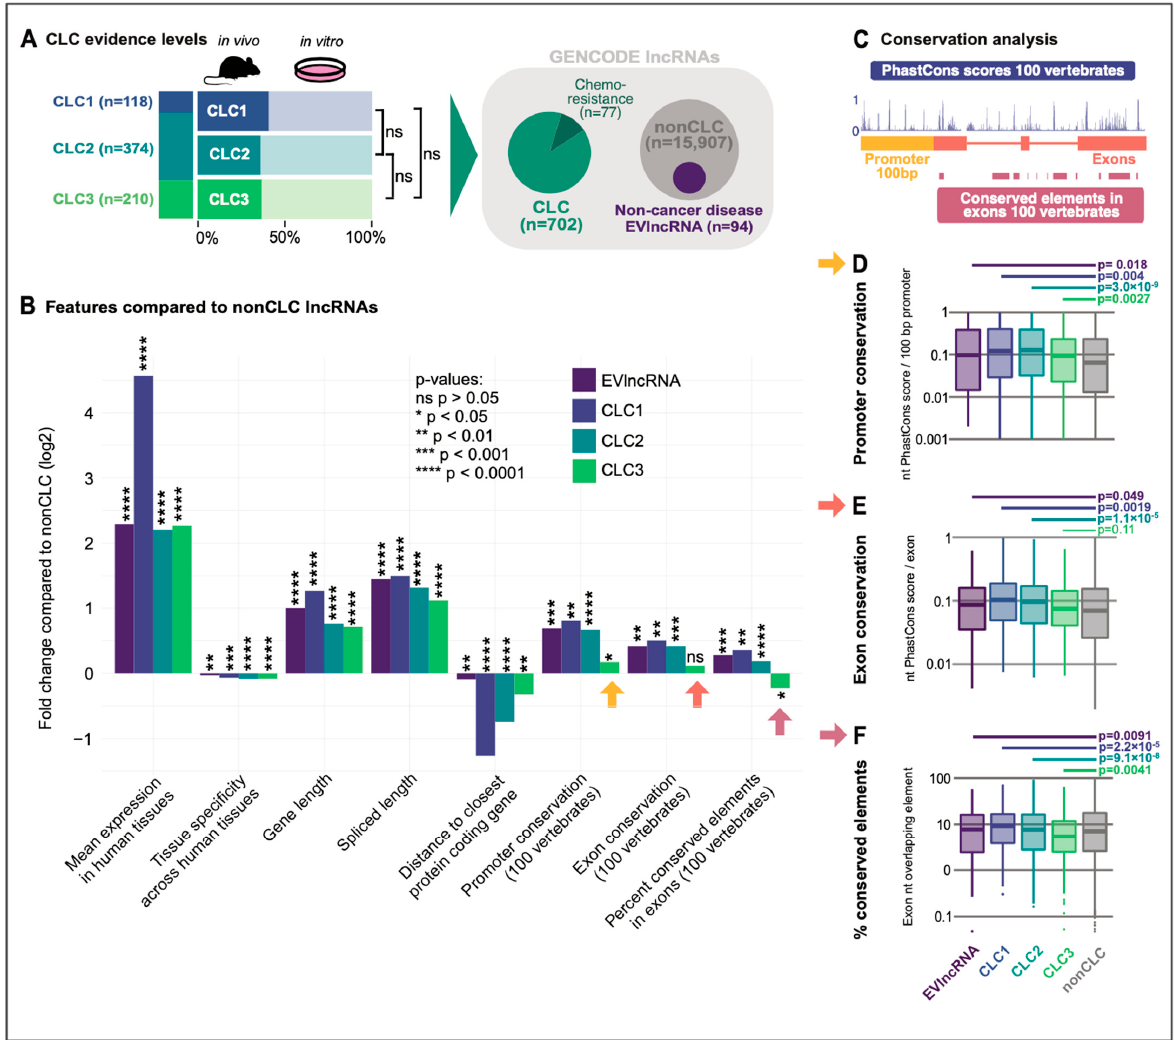
Figure 1. ( A ) Evidence levels for functional lncRNAs in CLC database versions. Dark colour indicates number of lncRNAs tested in an in vivo setting. No significant (ns) difference of in vivo enrichment is observed across the datasets. The full CLC consists of 702 lncRNAs with 77 lncRNAs exhibiting chemoresistance mechanisms. GENCODE lncRNAs are subdivided in CLC and nonCLC genes for further comparison. Non ‐ cancer disease EVlncRNAs are nonCLC genes indicating a disease functionality but not represented in the CLC database. ( B ) Features in datasets compared to nonCLC lncRNAs using LnCompare. ( C ) Overview of conservation analysis using 100 vertebrates comparisons. ( D ) Promoter conservation analysis for all datasets. ( E ) Exon analysis for all datasets. ( F ) Conserved elements analysis for all datasets.